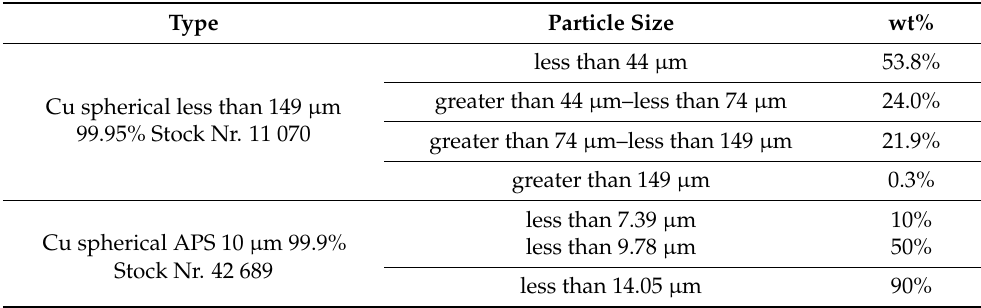
Table 1. Two different spherical-particle Cu metal powder